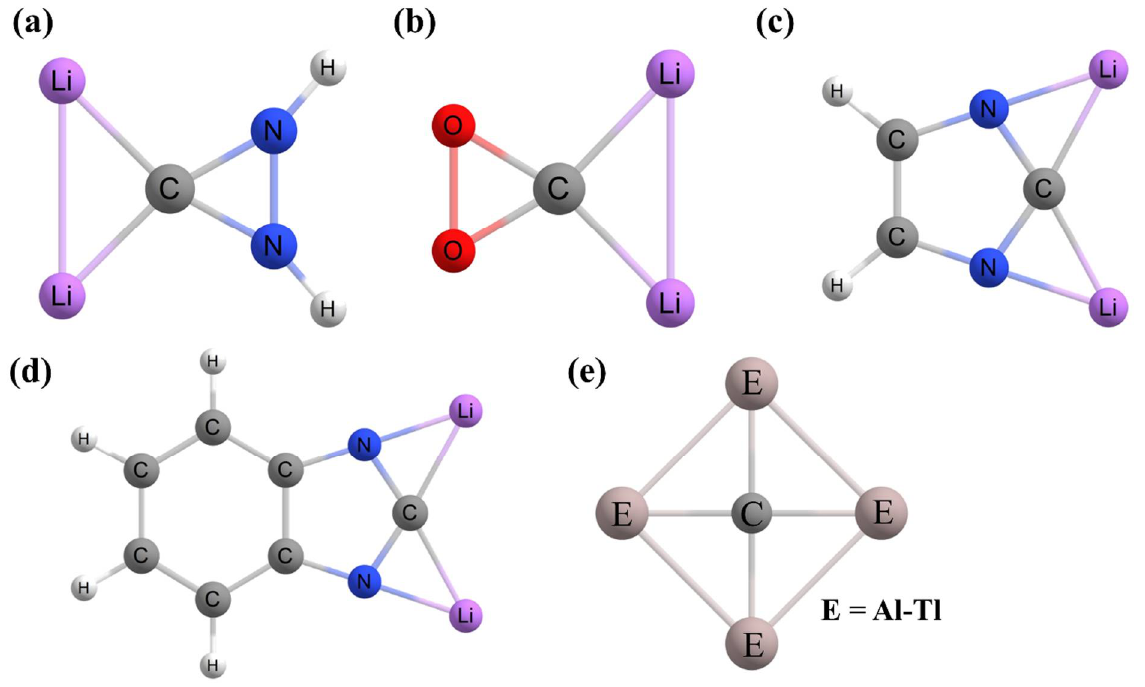
Figure 4. Optimized geometries of ( a – d ) computationally predicted dilithium ptC compounds. ( e ) The lowest energy structures of CE 42− clusters (E = Al, Ga, In, Tl), the systems have the same shape but different bond lengths.